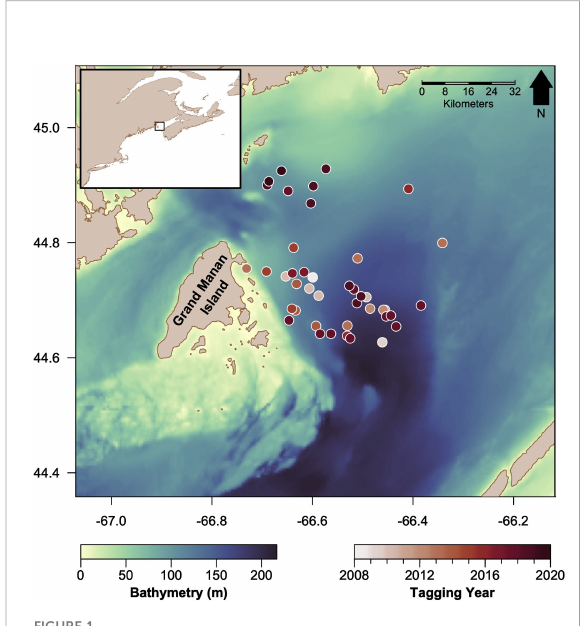
FIGURE 1 Map of the Bay of Fundy study area, the bathymetry of the basin (darker colors indicate deeper waters), and tagging locations of basking sharks in circles (darker colors indicate more recent years). The inset map (top left) shows the study region (black rectangle) relative to the western North Atlantic